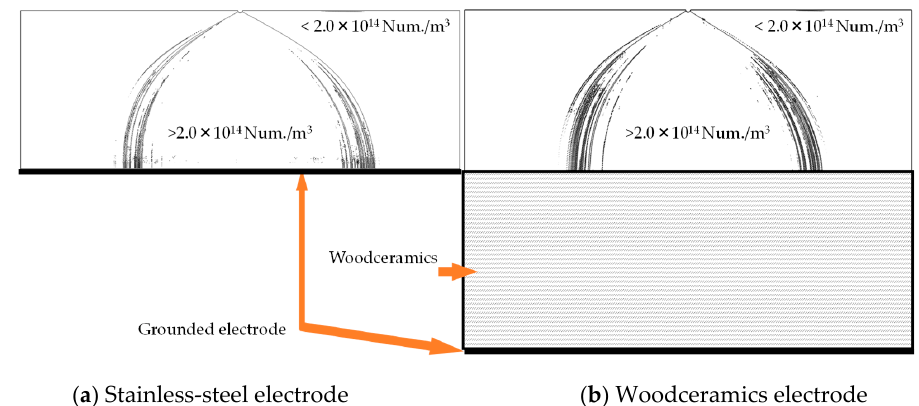
Figure 3. Illustration of the charge number densities of charges at the ( a ) stainless-steel grounded electrode and ( b ) the woodceramics electrode. These distributions are similar in shape to the charge distribution. It can be seen that the resistivity of the grounded electrode does not have strong influence on the overall charge distribution.